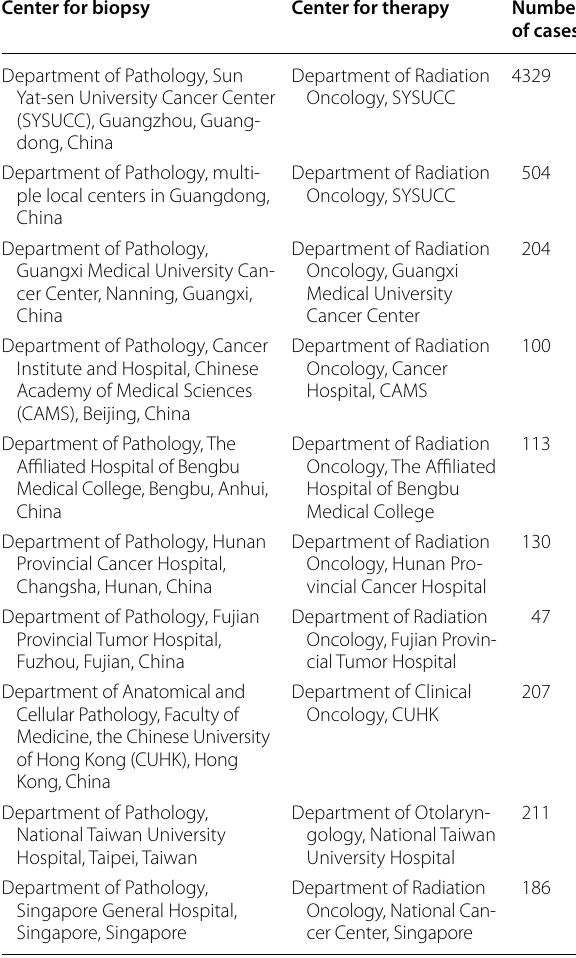
Table 2 Distribution of clinical centers where the 6031